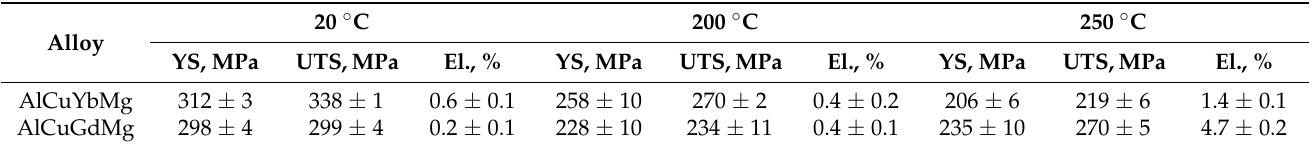
Table 4. Tensile test results at indicated temperature .